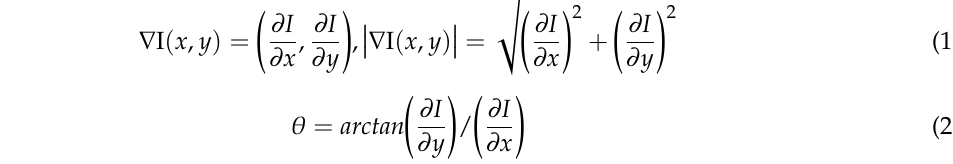
Figure 1. The proposed novel approach to obstacle detection in unstructured environment.